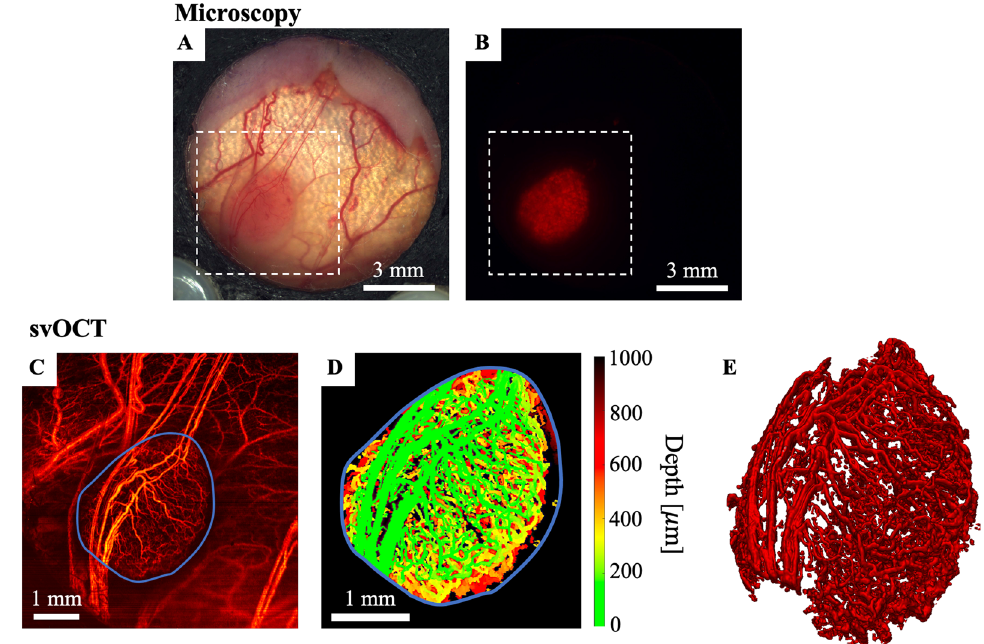
Figure 2. Brightfield, fluorescence, and svOCT imaging of a well vascularized tumor. ( A) Brightfield image of window chamber with white dotted line indicating the field of view of the svOCT image. ( B) Corresponding DsRed fluorescence image to indicate tumor cell viability. ( C) svOCT average intensity projection with tumor boundary delineated by the blue line. ( D) Segmented depth encoded vasculature within blue tumor boundary line. ( E ) 3D rendering of segmented tumor vasculature. ( C )–( E ) were generated using MATLAB R2020A software (MathWorks, Inc., Natick, MA,